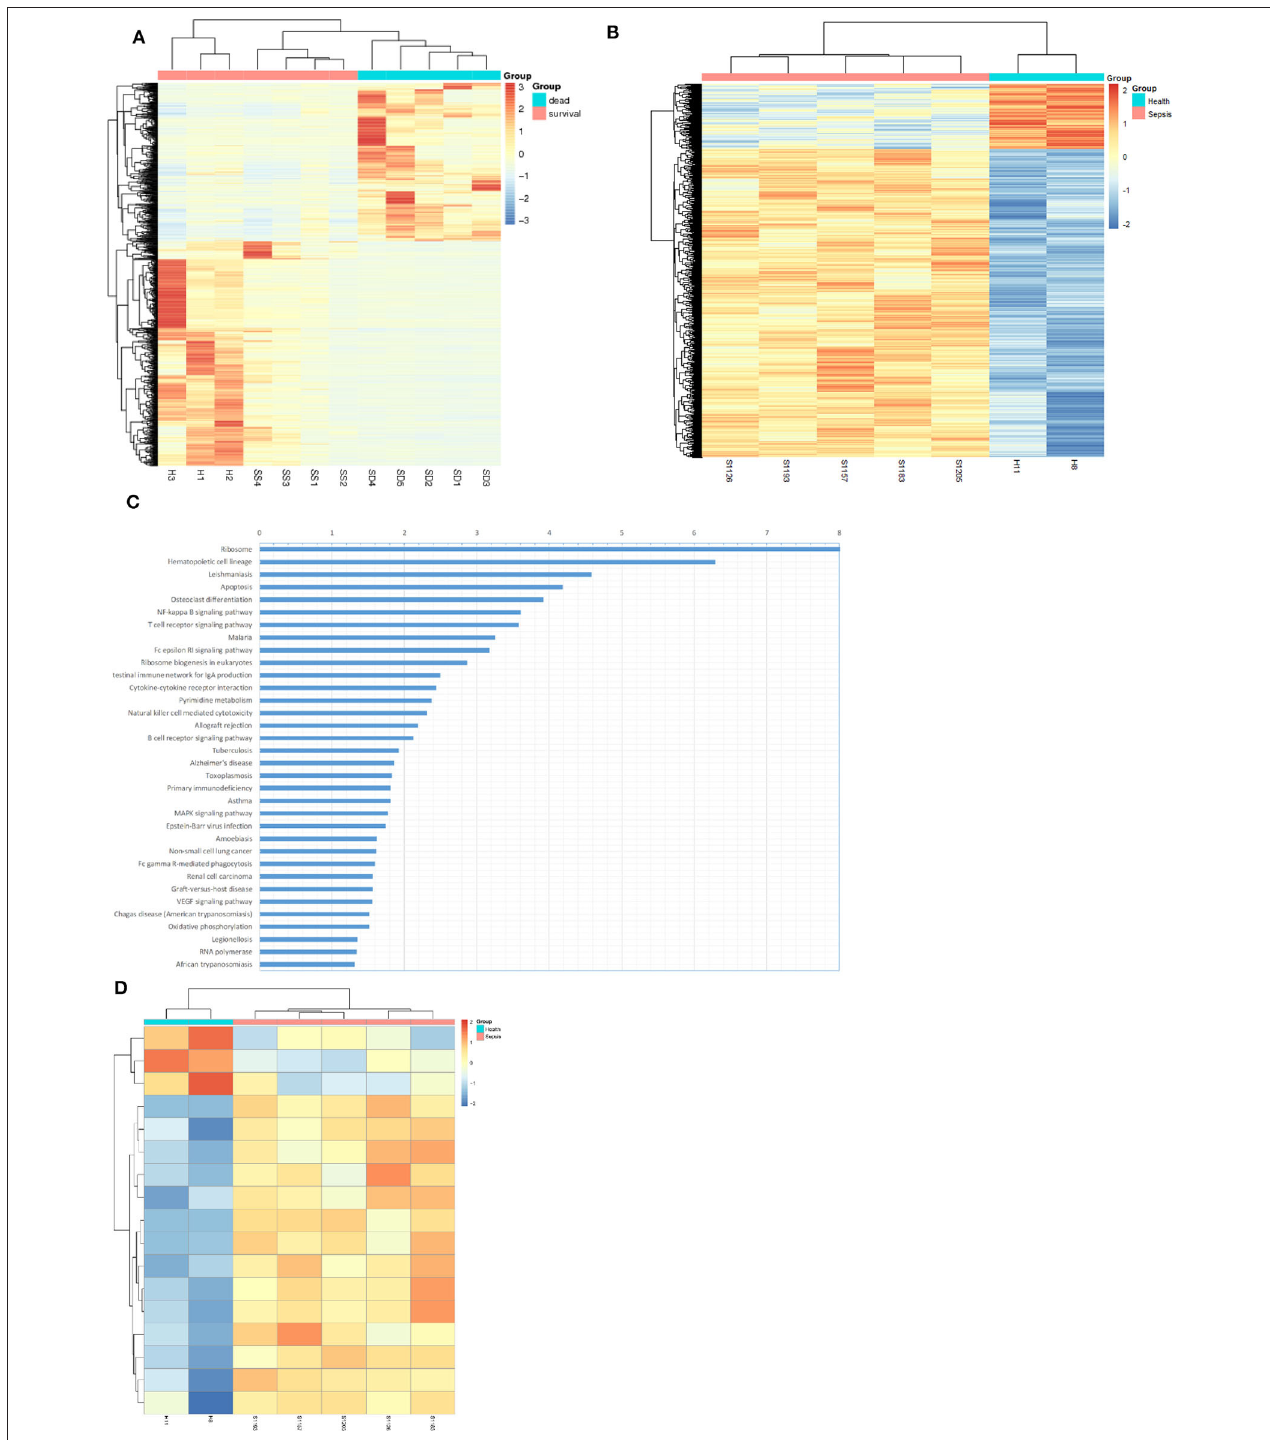
FIGURE 1 | Bioinformatics analysis suggested up-methylated NF-KB pathway related genes in patients with sepsis. (A) Hierarchical clustering and heat map of differentially expressed genes in survival sepsis patients, dead sepsis patients, and control. The scaled expression value is shown in a blue-red color scheme with red indicating higher expression, and blue lower expression (FDR ≤ 0.05 AND |log 2 Ratio| ≥ 1). (B) Hierarchical clustering and heat map of methylation variable positions in sepsis patients and control. The scaled expression value is shown in a blue-red color scheme with red indicating up-methylated, and blue down-methylated ( p < 0.01). (C) Kyoto Encyclopedia of Genes and Genomes (KEGG) enrichment analysis of DEGs ( p < 0.05). (D) Hierarchical clustering and heat map of NF- κ B pathway related genes in methylation variable positions ( p < 0.01).